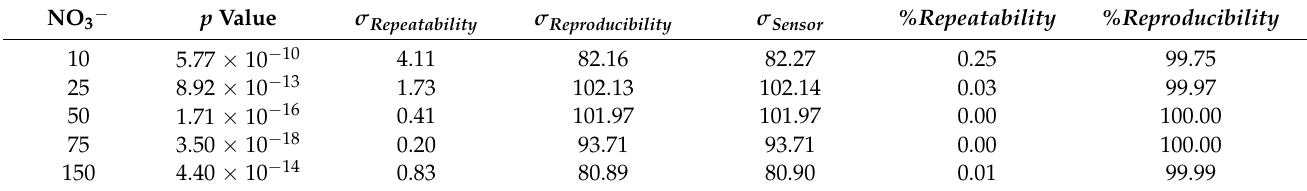
Table 5. Gauge Repeatability and Reproducibility study for Nutrisens